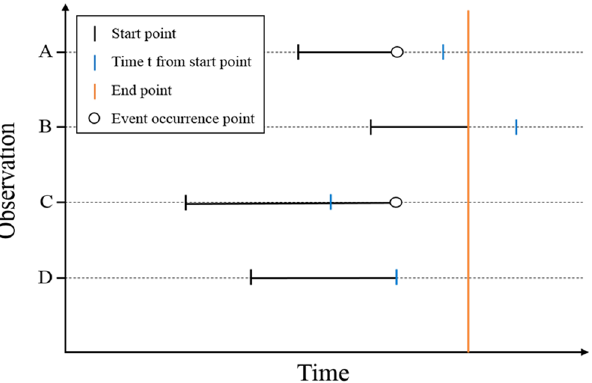
Figure 4. Limitation of conventional prediction model using censored data. The blue line indicates the time point ‘ t ’, from the starting point of observation, for each